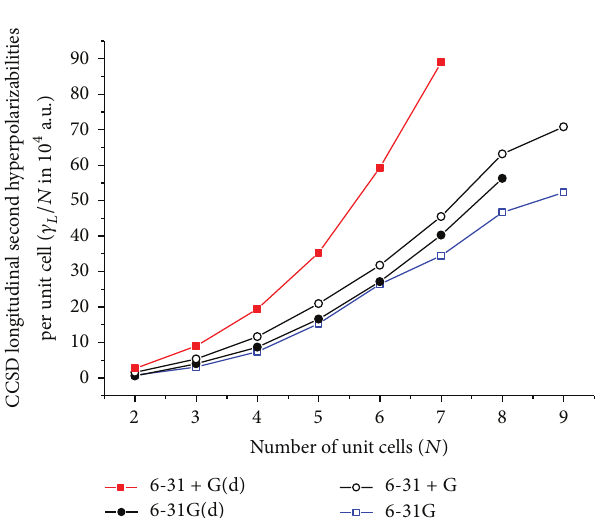
Figure 4: Longitudinal second hyperpolarizabilities per unit cell ( 𝛾 𝐿 /𝑁 , in 10 4 a.u.) obtained by CCSD with various basis sets.